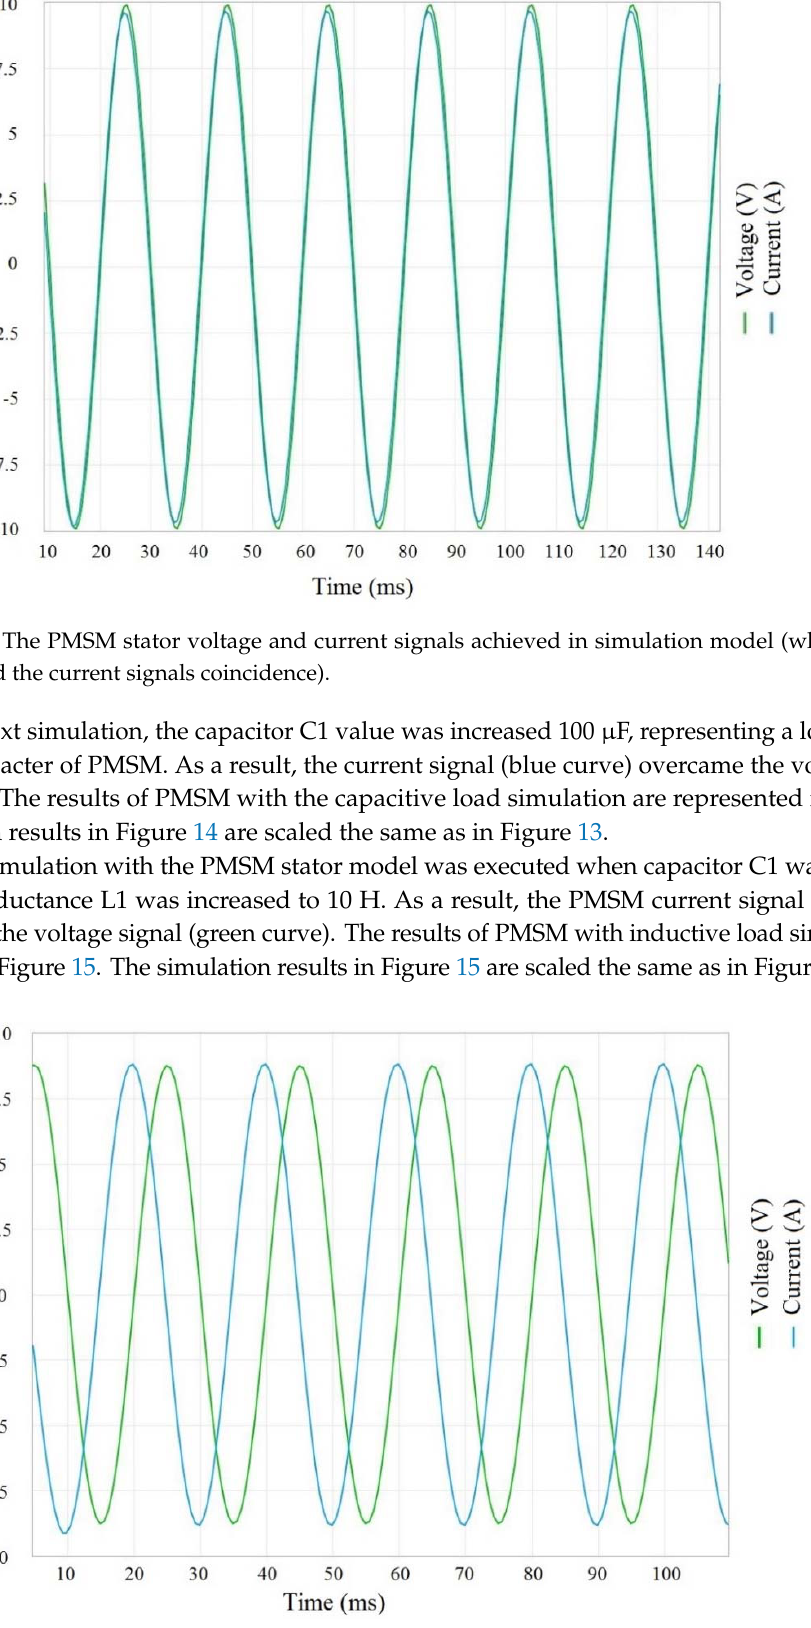
Figure 12. PMSM stator simulation model.